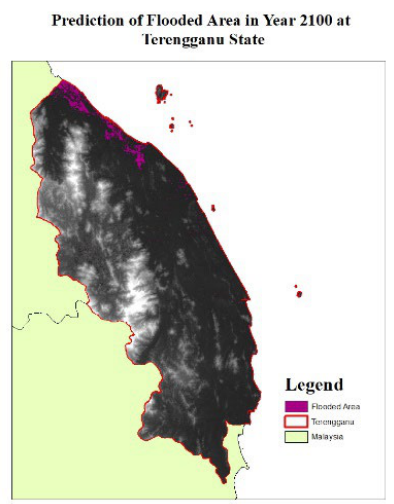
Figure 10. Maps of the affected areas over Terengganu state for the years 2040, 2060, 2080 and 2100